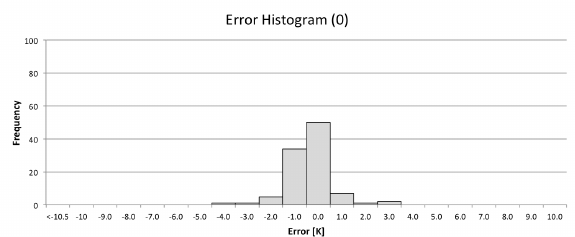
Figure 13: Histogram of error values for subset of Landsat 5 validation dataset processed using MERRA data, including only scenes that are cloud free over the ground truth site. scenes, processed using MERRA. The values shown in Table 5 are similar in magnitude to those shown in Table